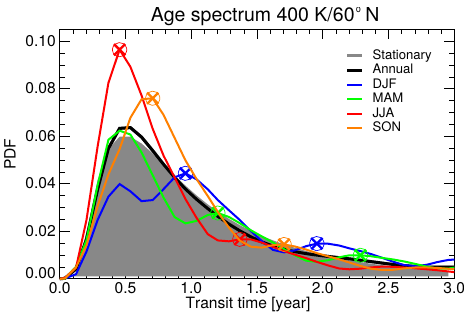
Figure 5. Seasonality of the climatological age spectrum at 400K in NH mid-latitudes (60 ◦ N). The annual mean spectrum is shown as a black thick line, the idealized stationary shape (see text) as grey shading, and different seasons as coloured lines. Symbols illustrate the evolution of the peak (see text for details).